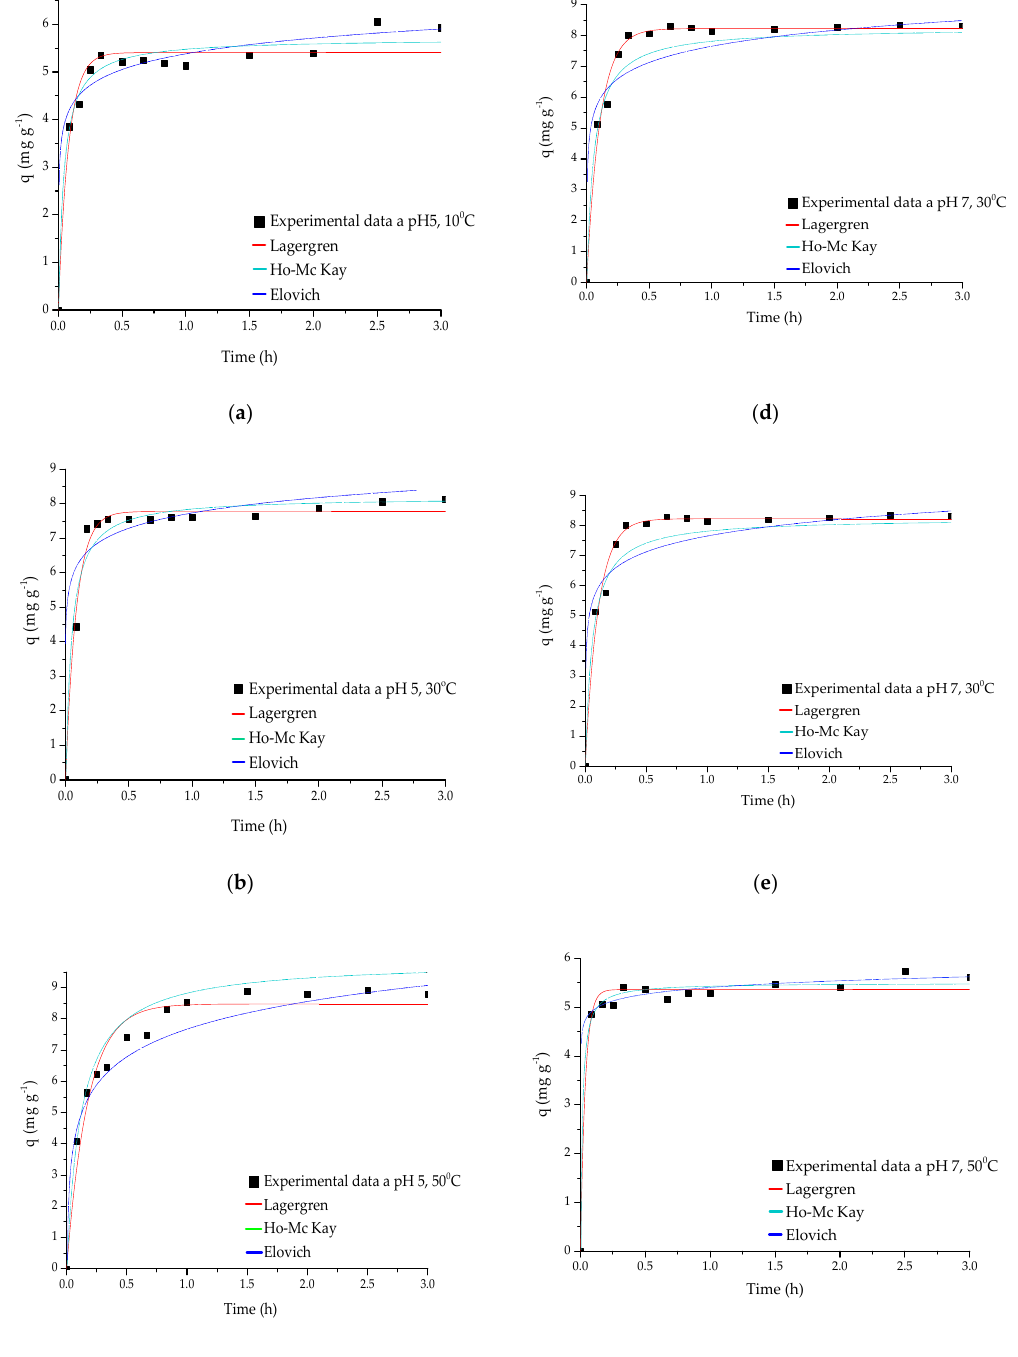
Figure 4. Adsorption kinetics ( a ) Q-PVA-NaOH-TPP (pH 5, T = 10 °C); ( b ) Ch-PVA-NaOH-TPP (pH 5, T = 30 °C); ( c ) Ch-PVA-NaOH-TPP (pH 5, T = 50 °C); ( d ) Ch-PVA-NaOH-TPP (pH 7, T = 10 °C); ( e ) Ch-PVA-NaOH-TPP, (pH 7, T = 30 °C) and ( f ) Ch-PVA-NaOH-TPP, (pH 7, T = 50 °C).